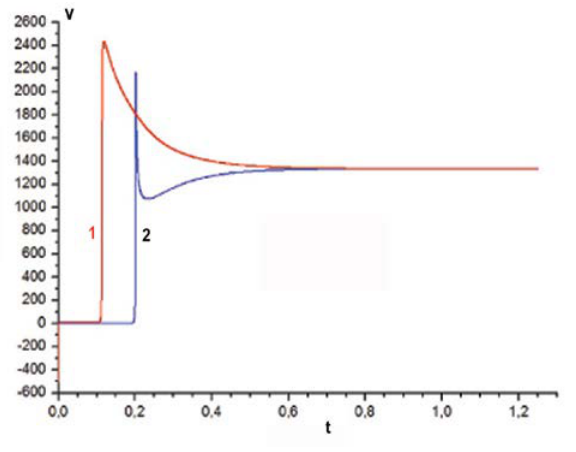
Fig. 4. Time dependence of vortex velocity at the surface (1) and in the middle (2) of the film.